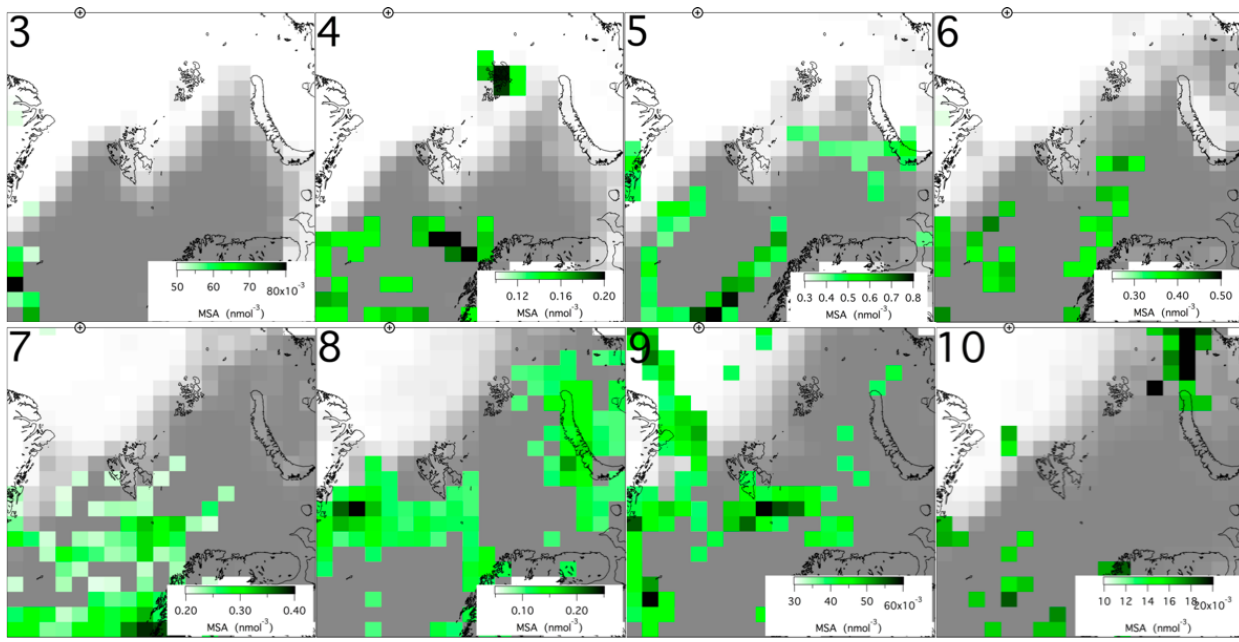
Figure 8. Average monthly distribution of methane sulfonic acid (MSA; nmolm − 3 ) , during the months March–October of the years 2006– 2015, constructed from MSA concentrations measured on Mt. Zeppelin, which were extrapolated along 5-day back trajectories. Average open-water percentages during the respective months are indicated as white (0% open water) to dark gray (100% open-water) areas. The position of the North Pole is marked as a cross in a circle on the upper border of the